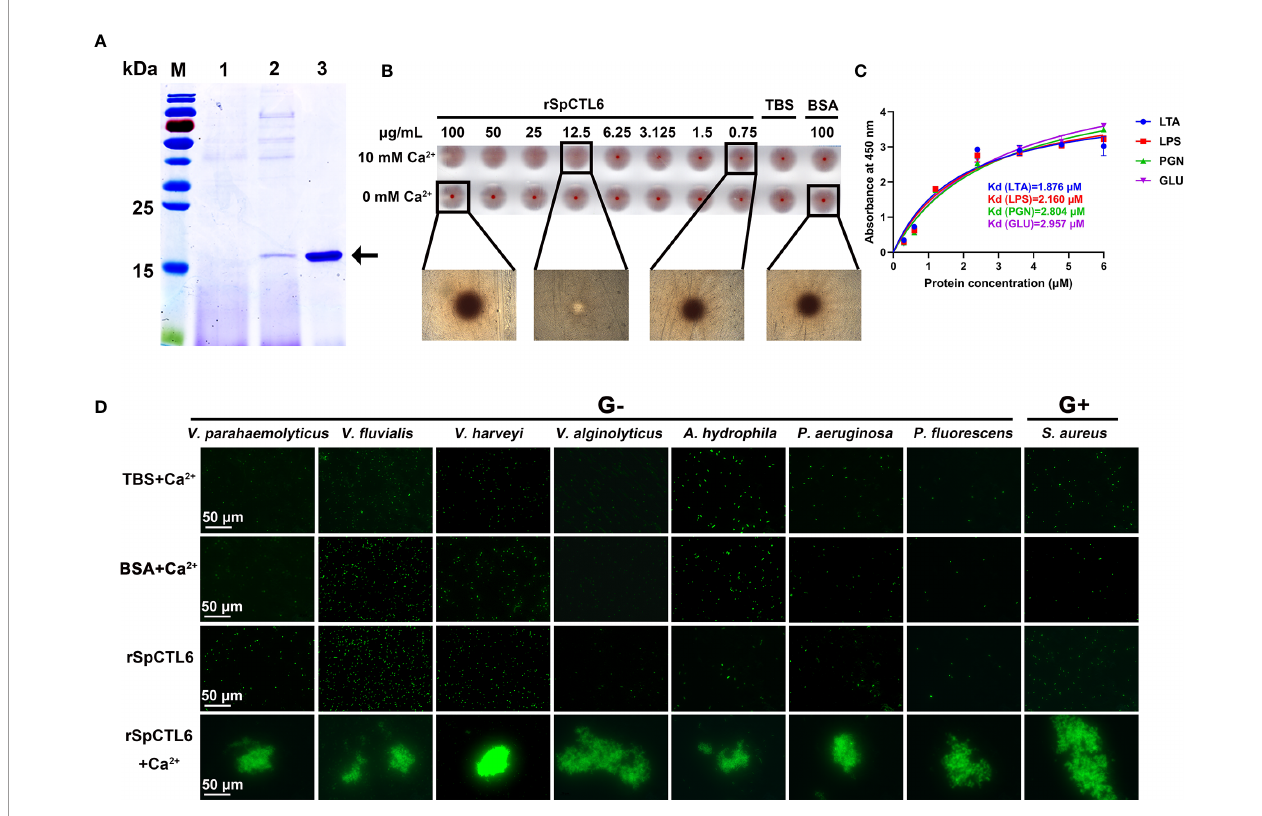
FIGURE 4 | Analysis of hemagglutination, agglutination and binding activity of rSpCTL6. (A) Expression and puri fi cation of recombinant SpCTL6. Lane M: protein molecular standard; lane 1: negative control for rSpCTL6 without methanol induction; lane 2: expression of rSpCTL6 after methanol induction; lane 3: puri fi ed rSpCTL6. (B) Agglutination activity of rSpCTL6 on mouse erythrocytes. (C) Binding activity of rSpCTL6 to PAMPs (LTA for lipoteichoic acid, LPS for lipopolysaccharide, PGN for peptidoglycan, GLU for glucan). (D) Bacterial agglutinating activity of rSpCTL6 on FITC-labeled Gram-negative bacteria (G - ) V. parahaemolyticus , V. fl uvialis , V. harveyi , V. alginolyticus , A hydrophila , P. aeruginosa , P. fl uorescens , and Gram-positive bacteria (G + ) S. aureus . The concentration of CaCl 2 was 10 mM. TBS and BSA were used as control groups.